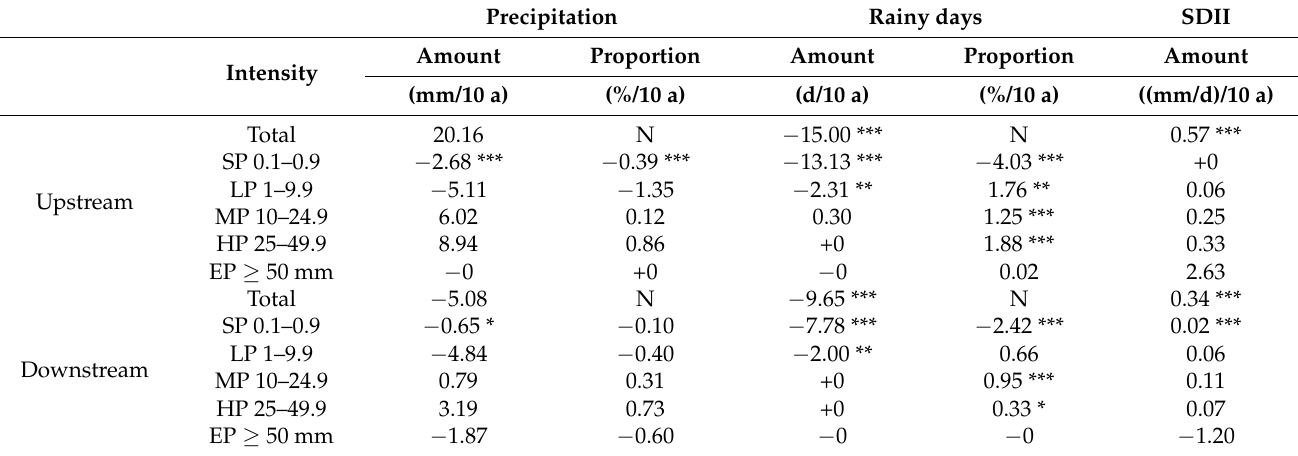
Table 2. Trends of precipitation, rainy days, and SDII in each intensity over the LRB during 1977–2017. Precipitation Rainy days SDII Amount Proportion Amount Proportion Amount Intensity